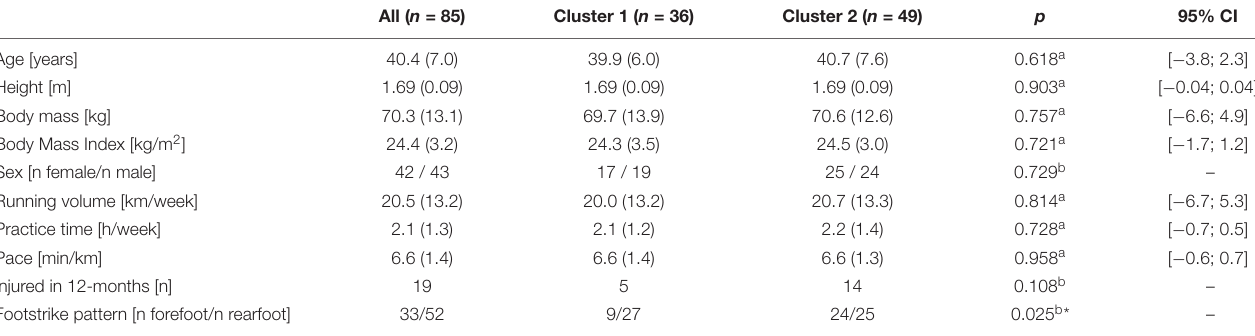
FIGURE 1 | Dendrogram resulting from the hierarchical cluster analysis, representing element combinations and dissimilarity level for each pairing. Cluster 1 is represented by the red lines and cluster 2 by the blue lines. TABLE 1 | Mean (SD) and distribution of demographic and running practice characteristics, and number of injured runners by the end of the clinical